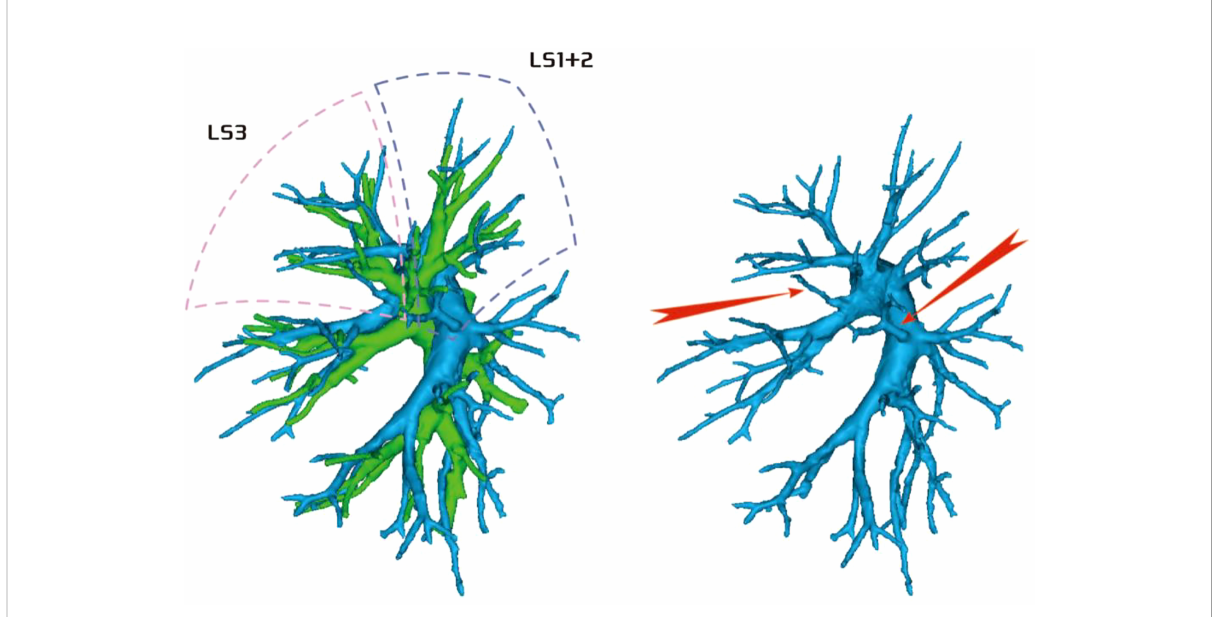
FIGURE 3 Dotted line is the area of LS3 and LS1 + 2. The red arrow indicates the branch of the lingular artery entering LS1 + 2 and LS3 at the same time.